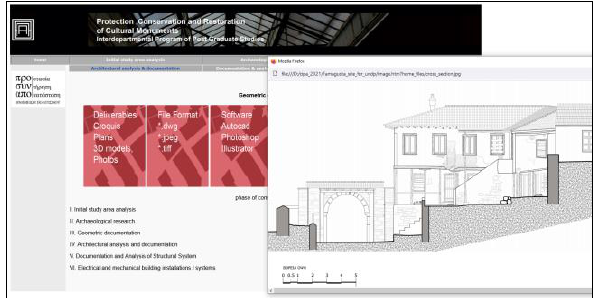
Figure 12 . Layout of the multimedia application (presentation of Architectural analysis and documentation / Architectural analysis / Geometric documentation / Example: Cross section drawing).